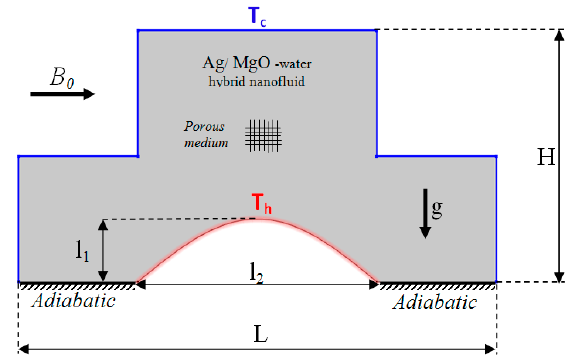
Figure 1. The geometry of the physical model.